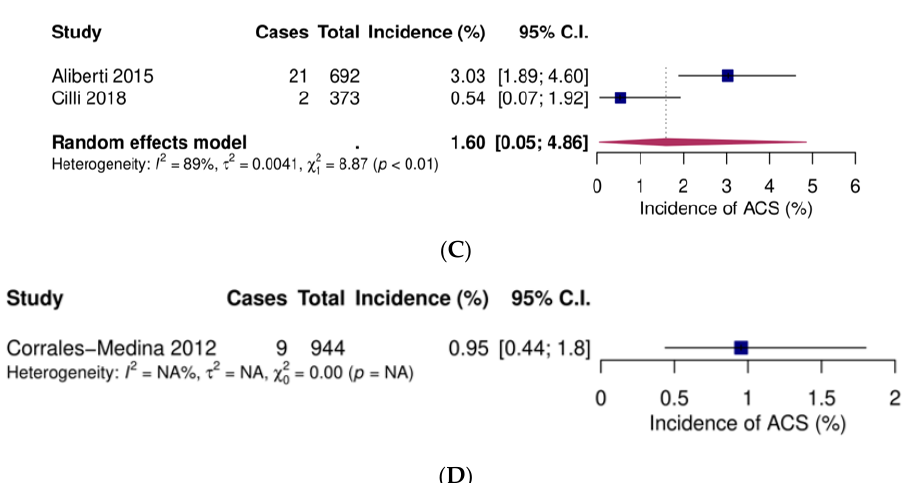
Figure 3. Forest plots of incident acute coronary syndromes (ACS) after community-acquired pneumonia. ( A ) Inpatients ( B ) Low-risk inpatients ( C ) High-risk inpatients ( D ) Outpatients. CI: confidence interval.